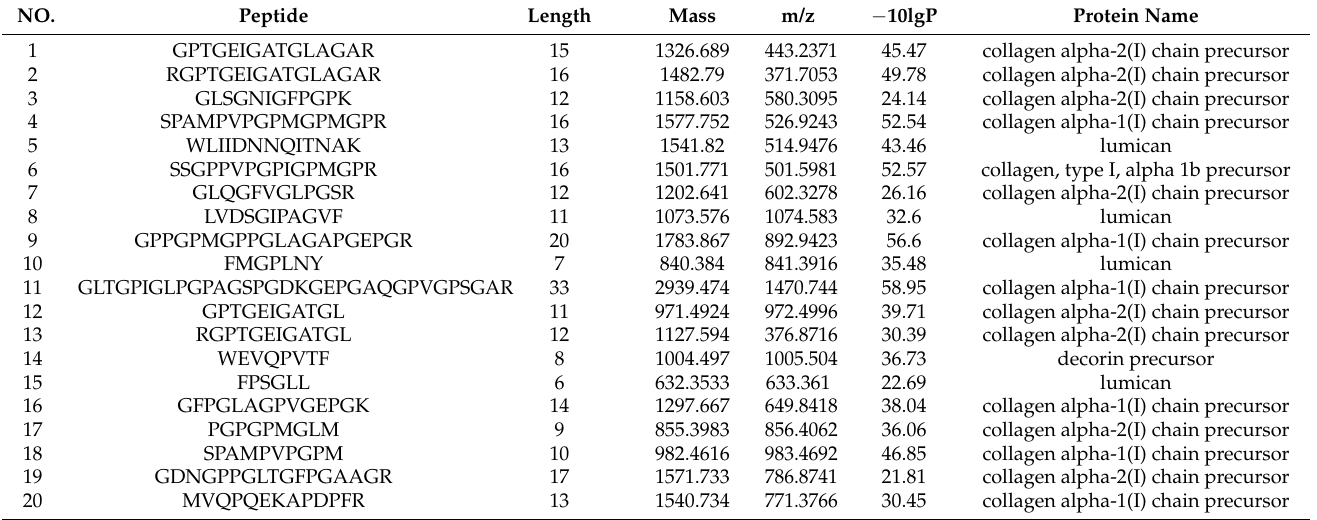
Table 3. List of the peptide sequences identified from APT and the associated proteins of the